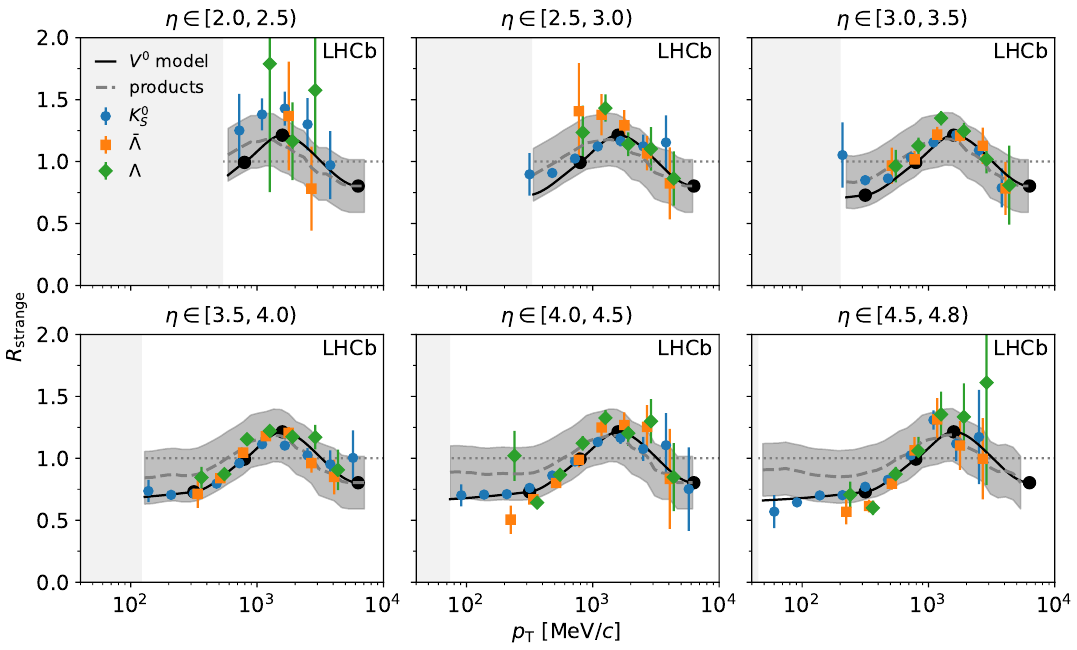
Figure 8 . Ratio of the proxies for strange-hadron decays in data and simulation in intervals of η and as a function of p T for the LHC fill recorded with the magnetic field pointing upwards and the simulated sample with the same magnetic-field configuration. The V 0 model lines indicate the interpolated K 0 , Λ and Λ yield ratios, with support points indicated by black dots. The lines S labelled as products represent the proxy ratio of the decay products, with the bands representing the propagated systematic uncertainty. The light-grey areas indicate the limit of the kinematic